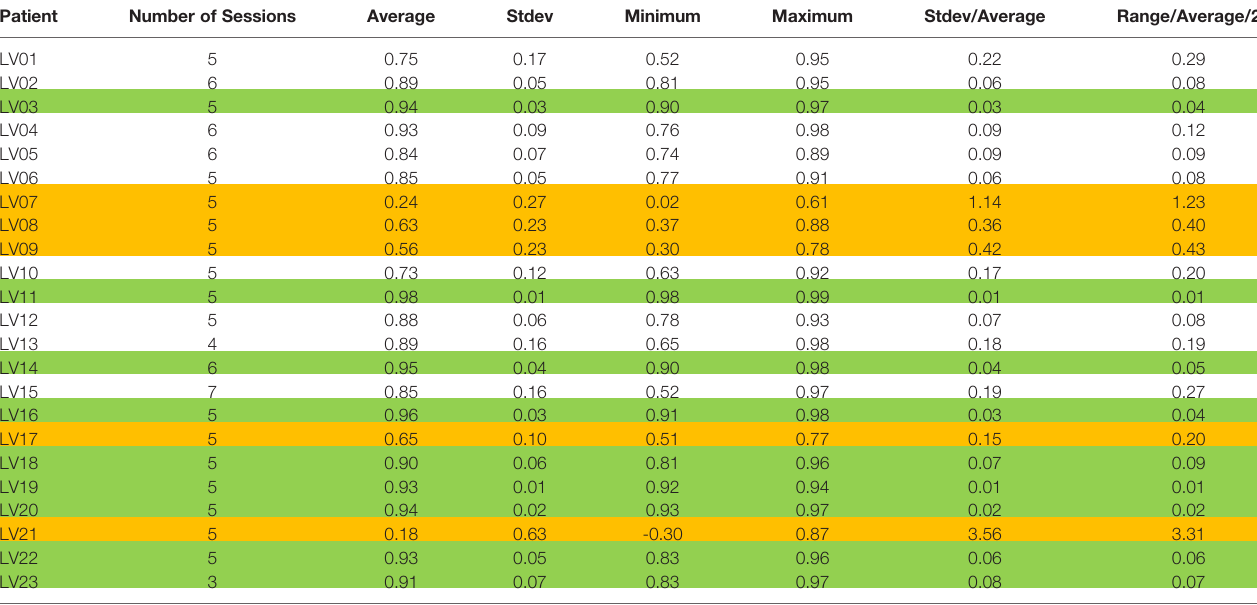
TABLE 2 | List of average, standard deviation (Stdev), minimum, and maximum correlation coef fi cients between SI and Belly for each patient.